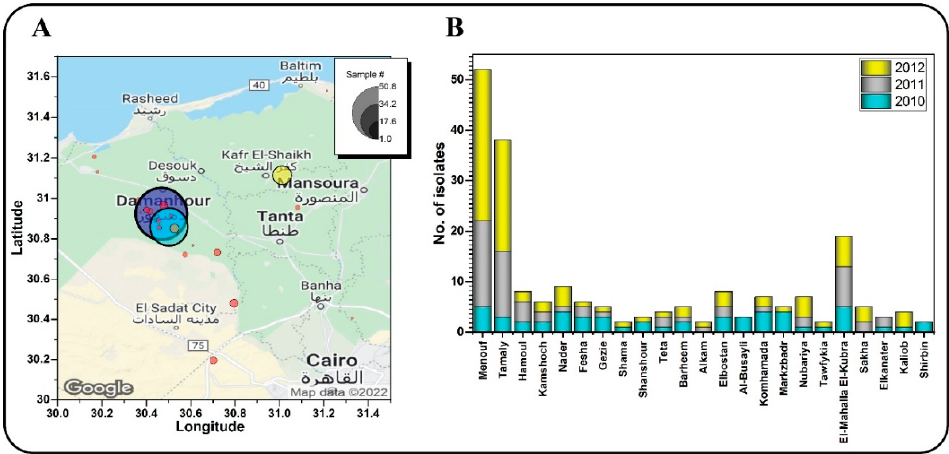
Figure 1. Density map of potato and tomato plants infected with P. infestans ( A ), and the number of isolates collected from 23 different locations in 6 Egyptian governorates during three growing seasons ( B ).